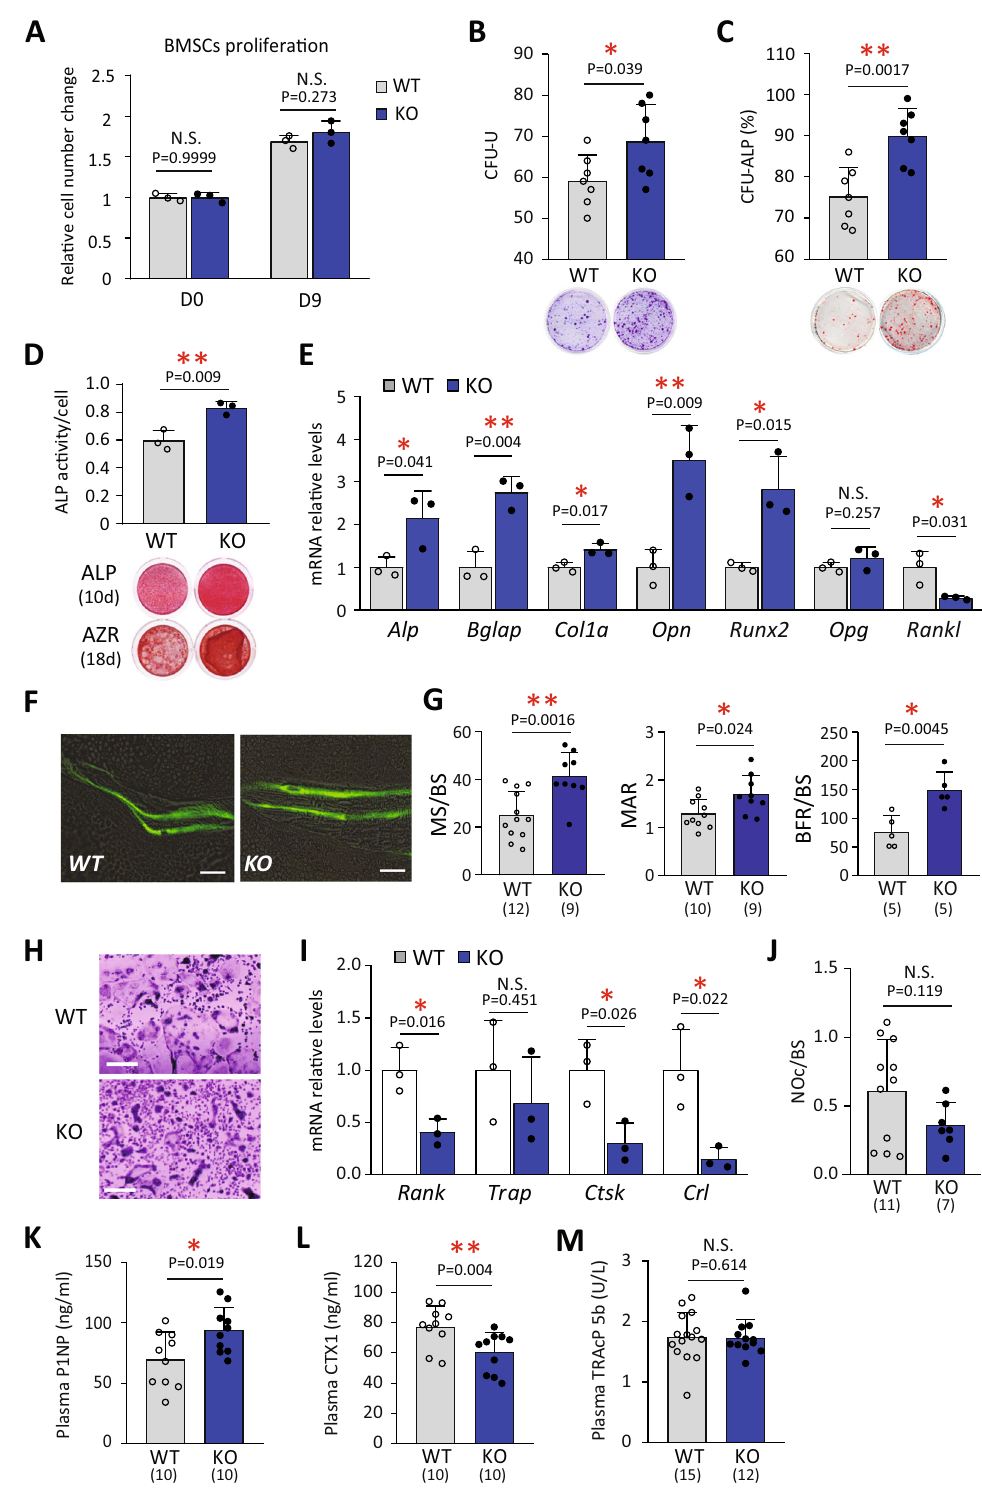
(Fig. 6G).Theresultssuggestthatbothintegrin and CD44 signaling are important for OB differentiation of hBMSC, but only integrin β 1 mediates the regulatory effects of KIAA1199-OPN on OB differentia- tion. To determine downstream signaling involved in KIAA1199-OPN interaction, we examined the major intracellular signaling pathways regulating OB differentiation. Inhibiting of KIAA1199 expression increased the activation of AKT and ERK phosphorylation